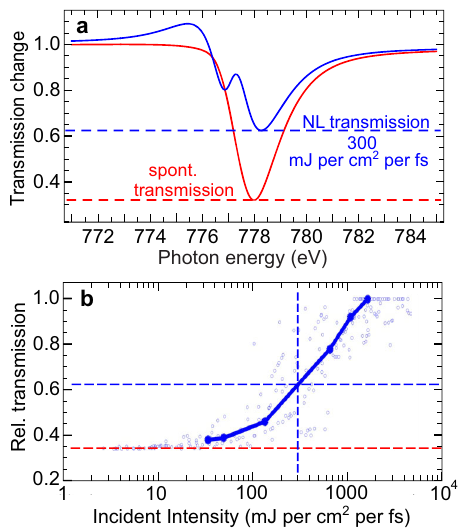
Fig. 6 Experimental and simulated dependence of X-ray transmission on X-ray intensity. Here, rel. stands for relative. a Spontaneous (spont.) and nonlinear (NL) transmission spectra taken from Fig. 3d, with horizontal dashed lines indicating the relative peak transmission values. b Reproduced with permission Fig. 3a of Chen et al. 23 . Light blue open circles represent the transmission response simulated by statistical modelling of the Self- Ampli fi ed Spontaneous Emission (SASE) pulses in conjunctions with the two-level optical Bloch equations. The thick solid blue line links experimental data points, averaged over multiple shots, for the same Co/Pd multilayer samples used